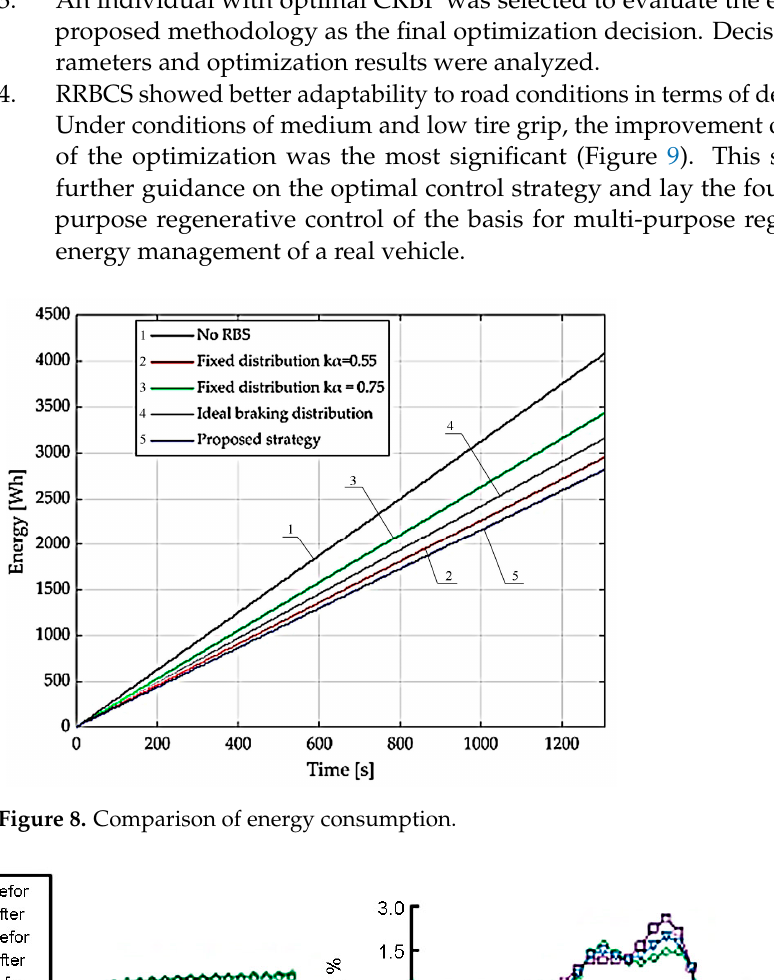
Figure 7. Change in overall efficiency.